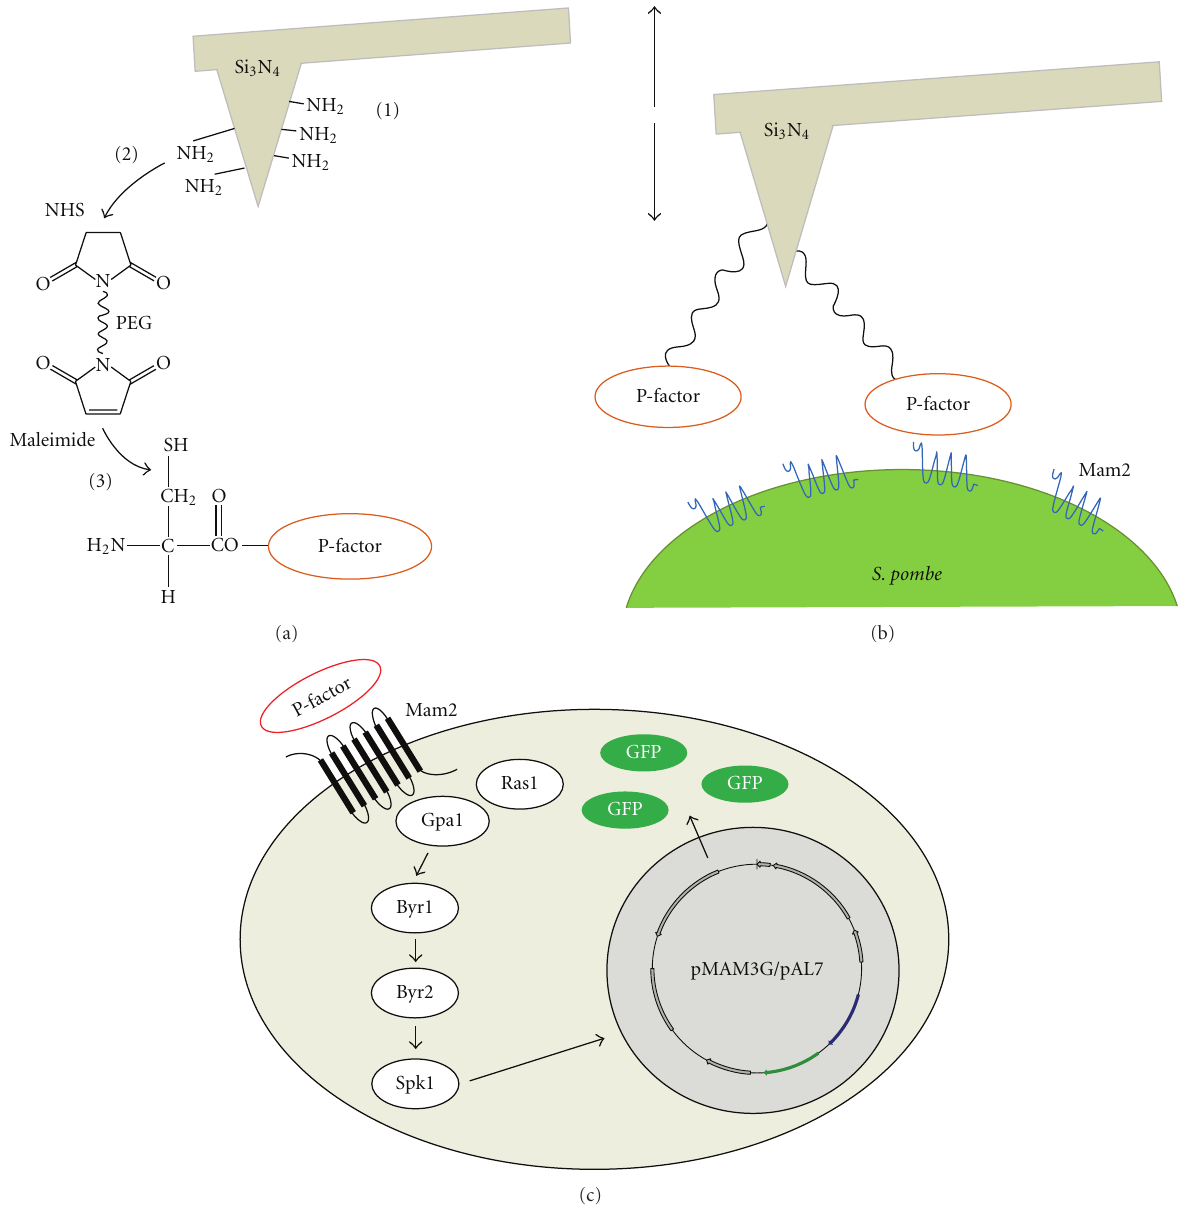
Figure 1: Schematic overview of experiments. (a) AFM tip modification with peptides. Si3N4 AFM tips are aminosilanized by exposure to APTES vapors. A heterobifunctional PEG linker is anchored to amino-group bearing tips through its NHS end. Peptide is attached to the PEG linker free end via a maleimide-cysteine bond. (b) Force spectroscopy method. Peptide-modified AFM tips approached the cell surface on a 200nm z-scan size at a speed of 1.74 μ m/s and were retracted at the same speed. (c) The reporter assay. Pheromone binding to its receptors on the cell surface activates the intracellular signaling pathway that leads to the expression of GFP. The released Gpa1 (Galpha) with GTP from a heterotrimeric G protein activates the MAP kinase cascade of Byr2 (MAP3K), Byr1 (MAP2K), and Spk1 (MAPK). Activation of Byr2 also requires